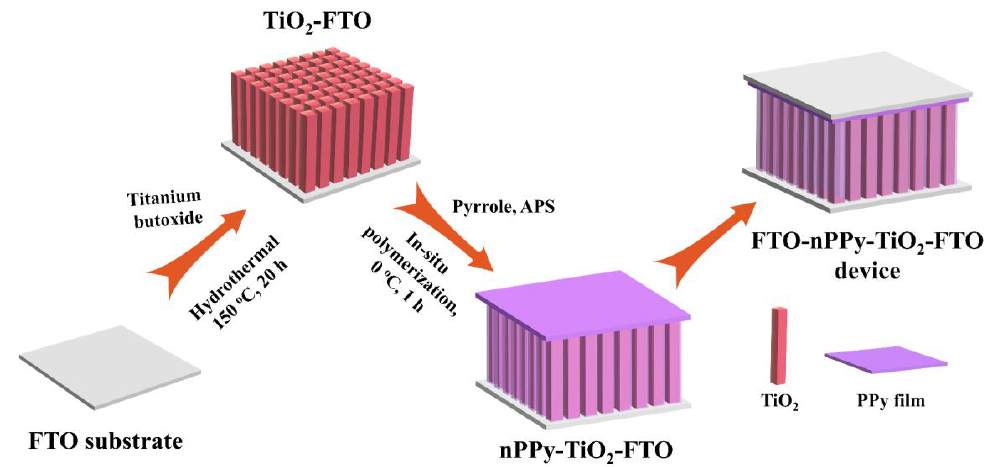
Figure 1. Schematic diagram of the fabrication of the FTO-nPPy-TiO 2 -FTO device.